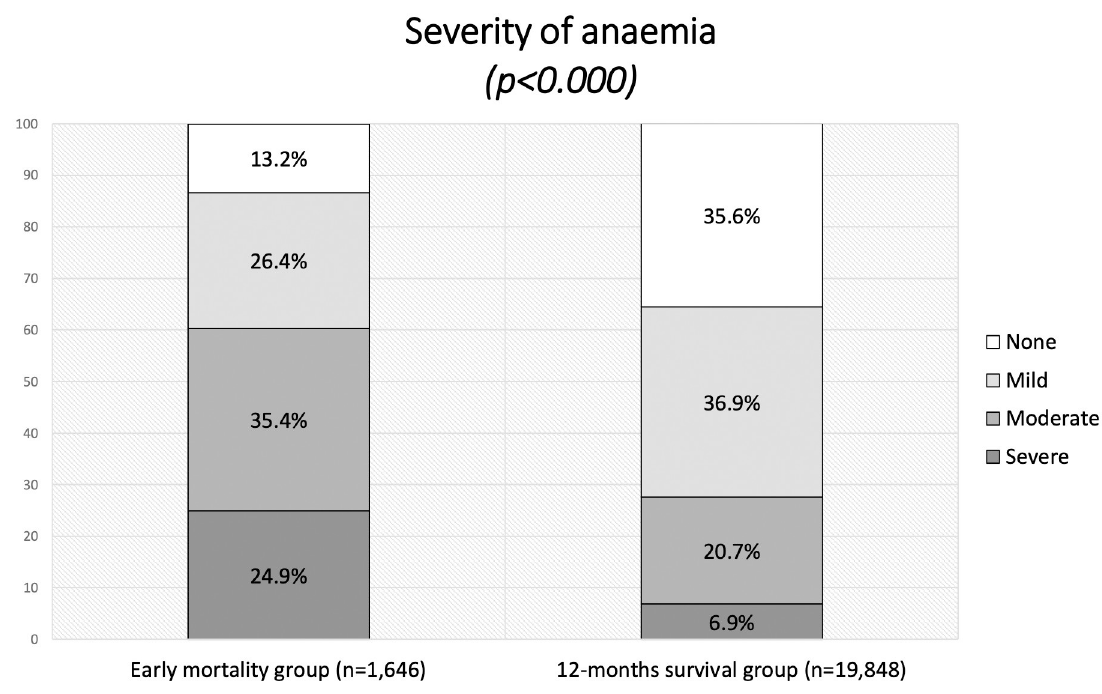
Fig 1. Severity of anaemia in early mortality and 12-month survival groups.